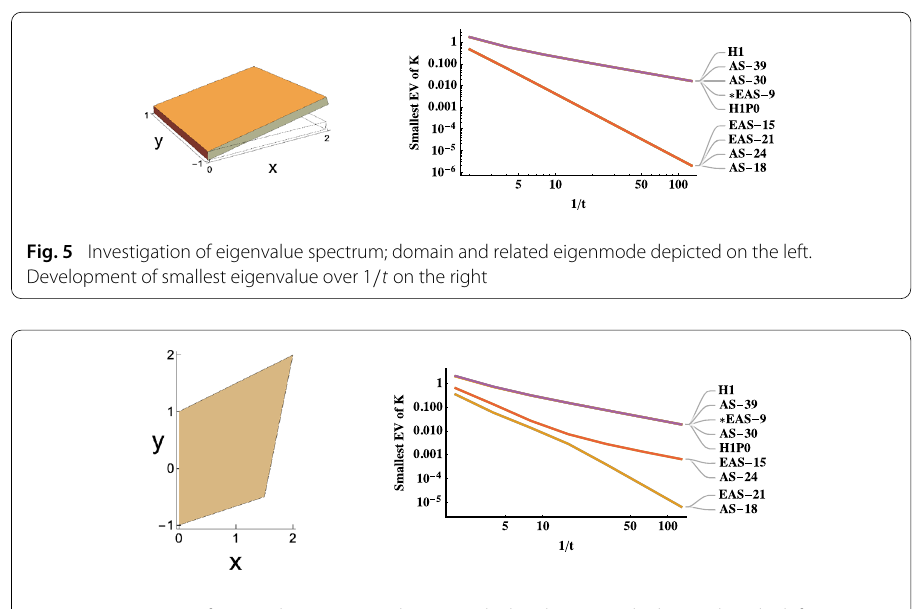
Fig. 6 Investigation of eigenvalue spectrum; domain and related eigenmode depicted on the left. Development of smallest eigenvalue over 1 / t on the